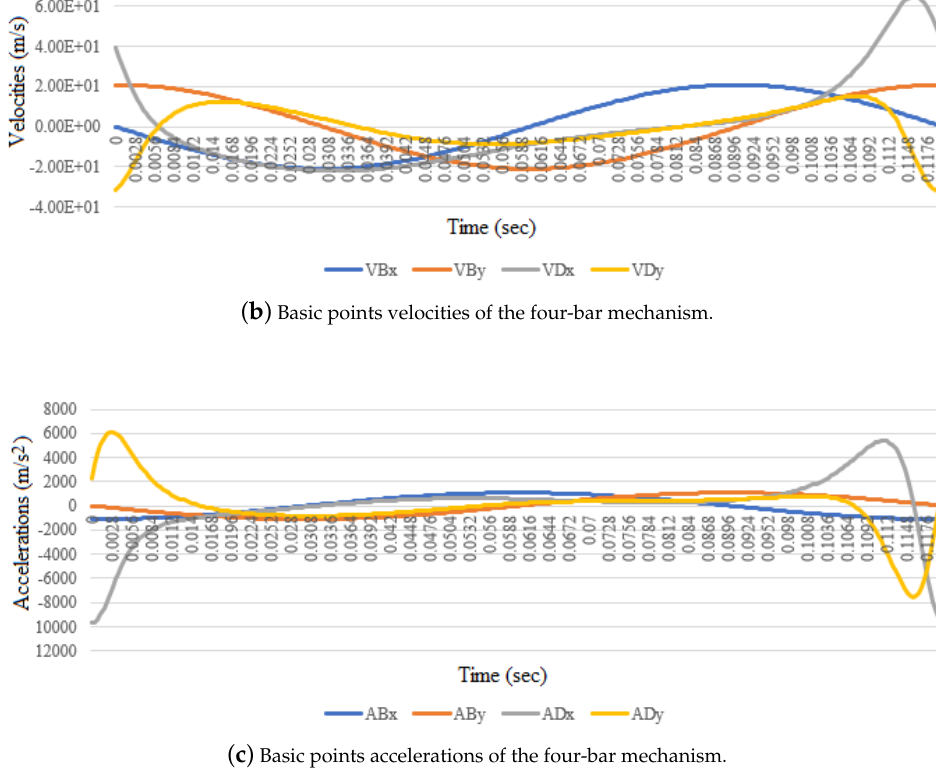
Figure 3. Direct kinematic results of the four-bar